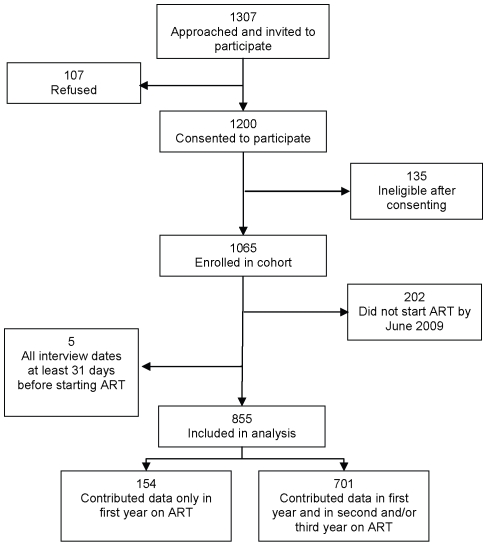
Study subject recruitment and inclusion for analysis.